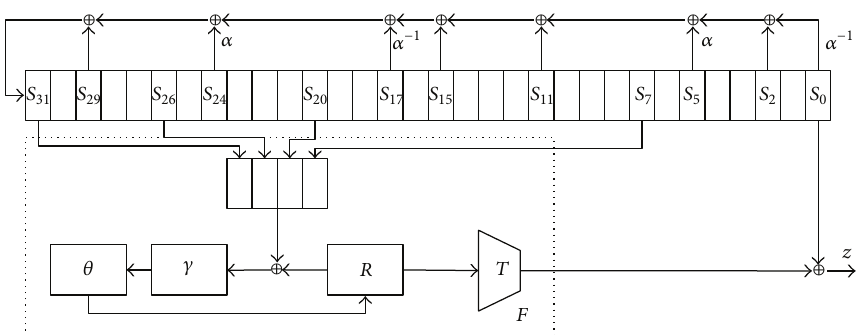
Figure 2: The structure of SD-Loiss stream